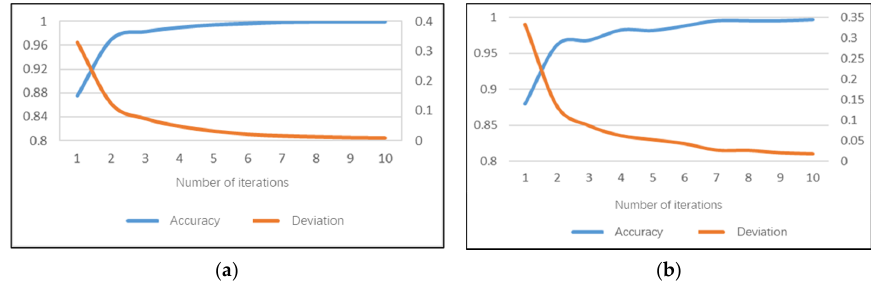
Figure 10. Training performance of hand posture set sub-model: ( a ) daytime; ( b ) night.